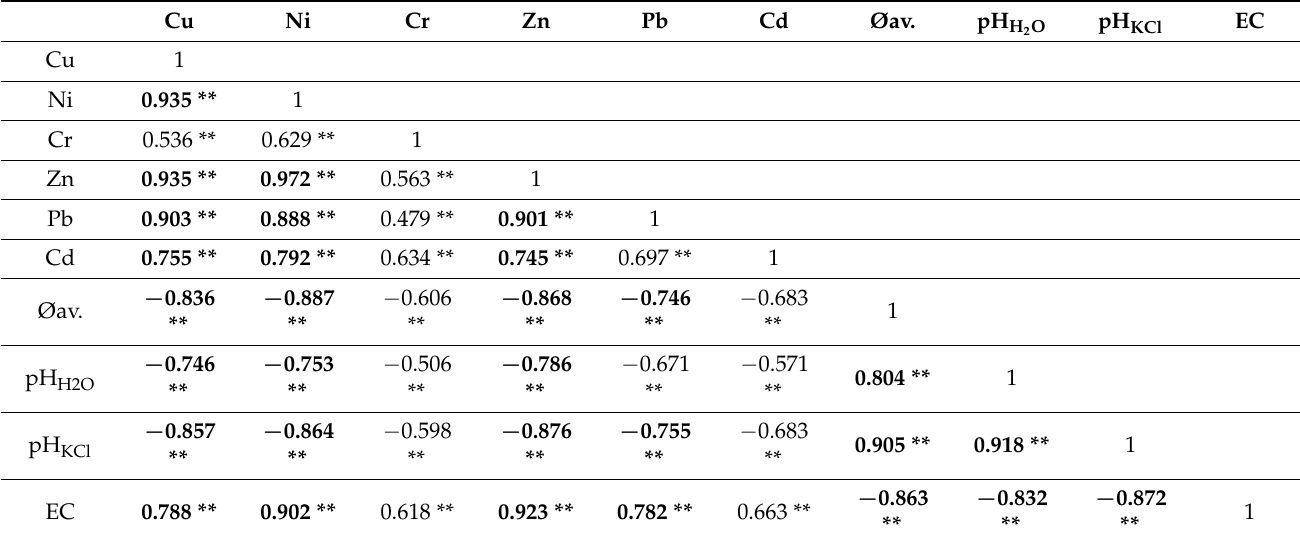
Table 9. Correlation matrix between the studied parameters of the bottom sediment near the hydropower plant on the ´Sl˛eza